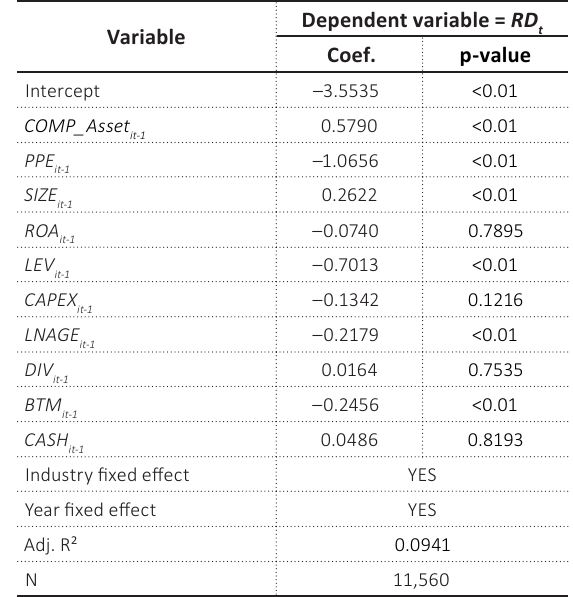
Table 6. Robustness test: Alternative measure